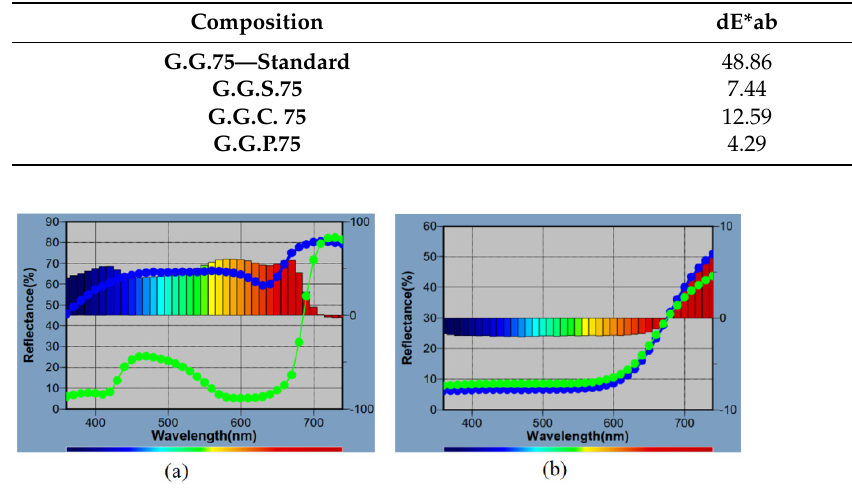
Table 11. Color changes of samples subjected to thermo-oxidative aging.